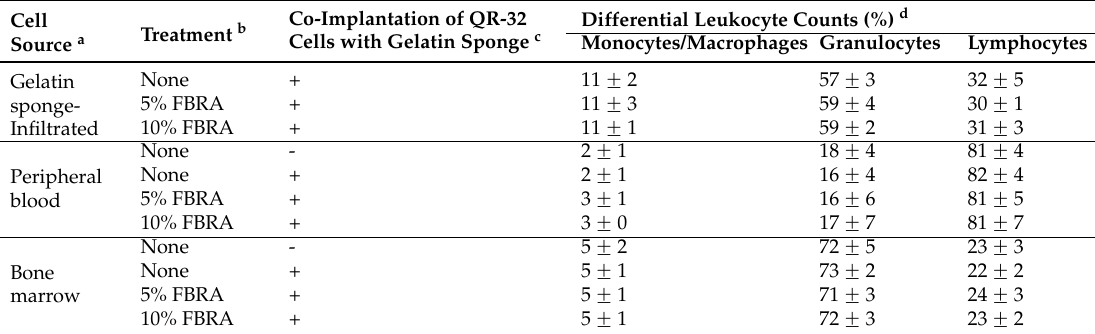
Table 5. Differences in leukocyte counts in mice with administration of